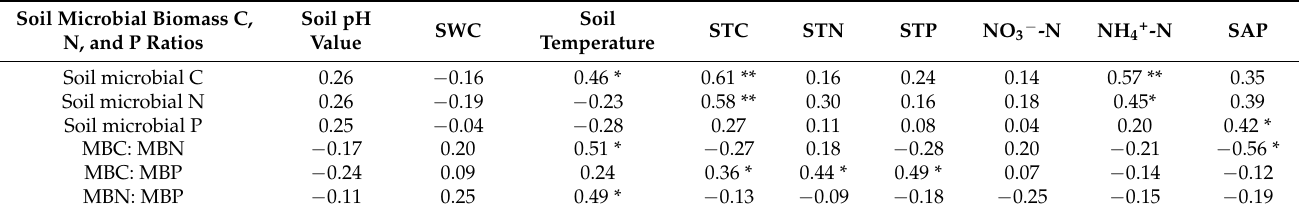
Table 4. Pearson correlation of microbial biomass C, N, and P ratios and pH value, moisture, temperature, and nutrient concentrations in soil across different thinning treatments.